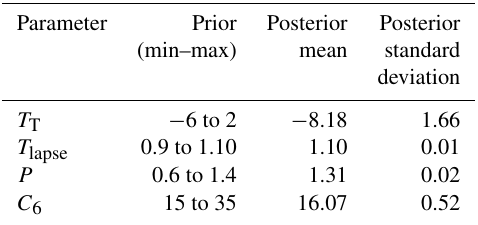
Table 6. Parameter value range prior to calibration and after calibra- tion. The standard deviation of posterior parameter values is based on the standard deviation of all